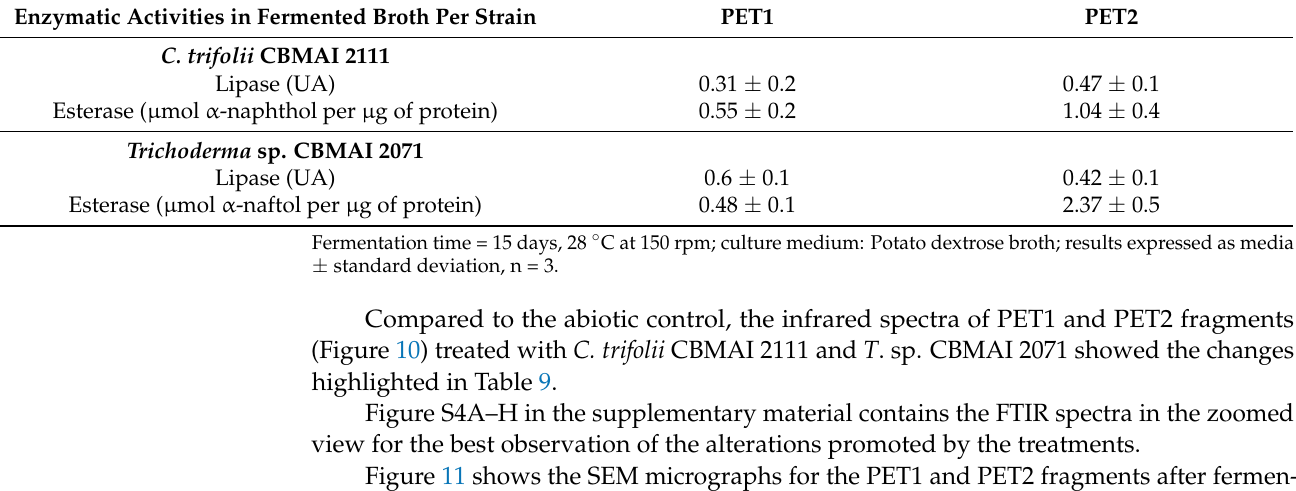
Table 9. Polymeric modifications on PET1 and PET2 after fermentation with T. sp . and C. trifolii using FTIR analysis.